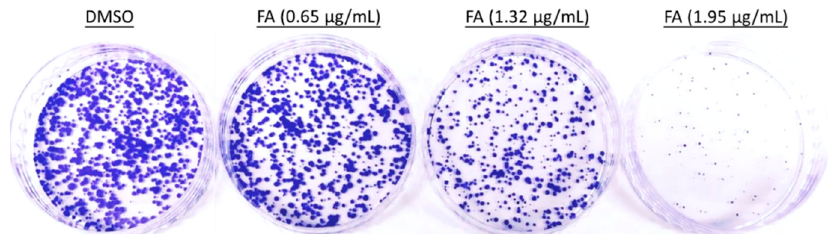
Figure 2. The inhibitory effect of FA on colony formation capacity in HCT-116 cells. In 6-well plates, clonogenic assay was performed post treatment with dimethylsulfoxide (DMSO) (0.5%) or FA at the indicated concentrations for 14 days, and cells in each well were stained with crystal violet at the end of the experiment. Shown are representative images from at least three independent experiments.